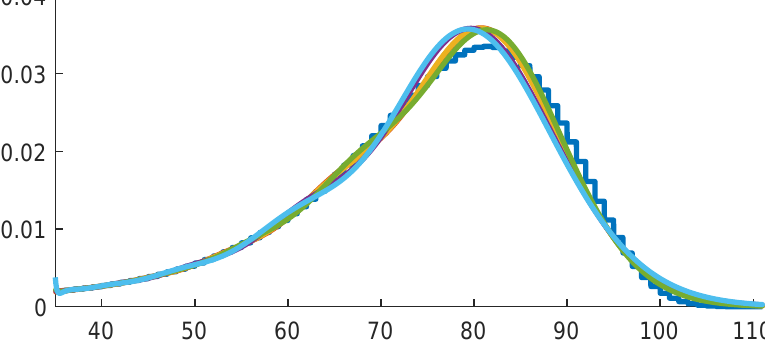
Figure 9. Fitted densities for five different seeds (against the life table